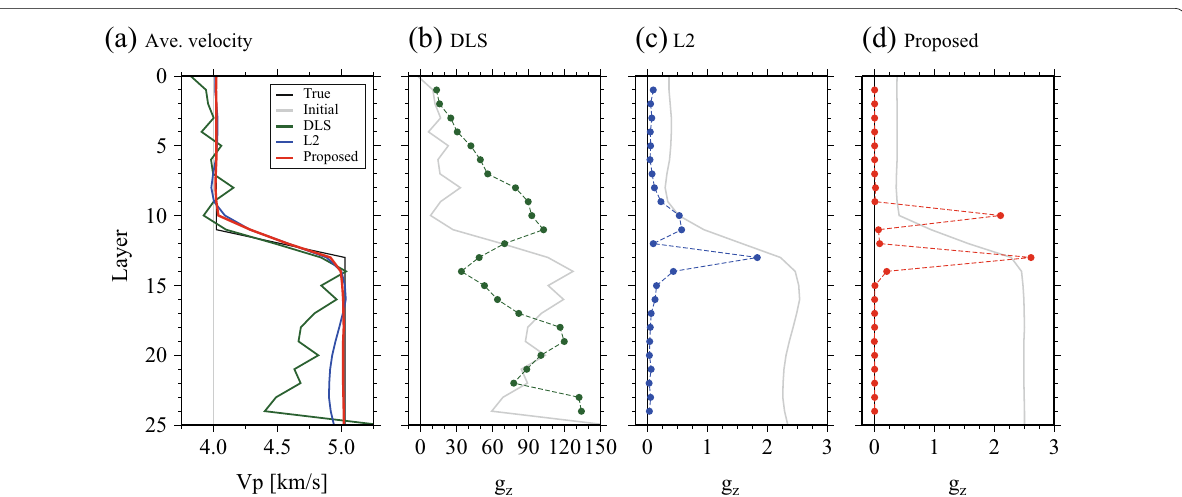
Fig. 4 a Comparison of the estimated average velocity structures. Estimates from DLS (green line), l 2 -smoothness regularization (L2; blue line), and the proposed method (red line) are shown. Black and grey lines illustrate the true and initial velocity structures, respectively. b – d g z values (colored circles), which are computed from the estimated average velocity structure for each method (grey